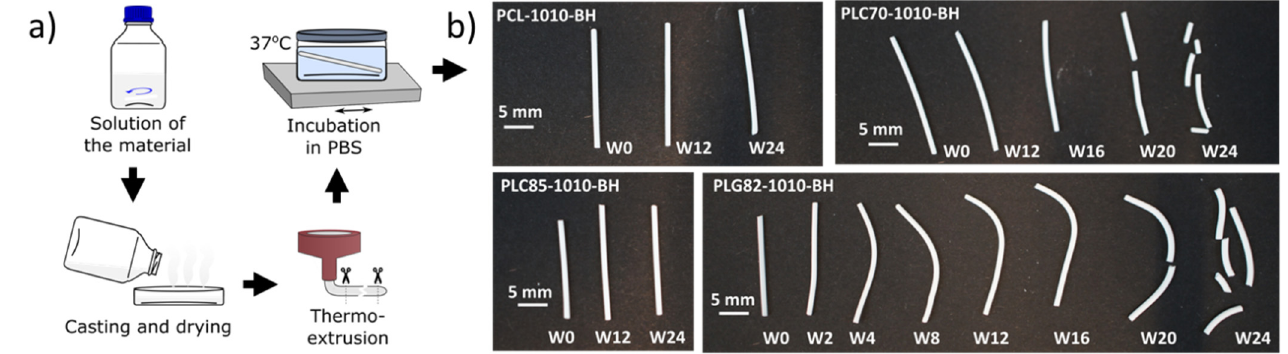
Figure 1. ( a ) Procedure of samples’ preparation; ( b ) photography of the samples after incubation in PBS at 37 °C.